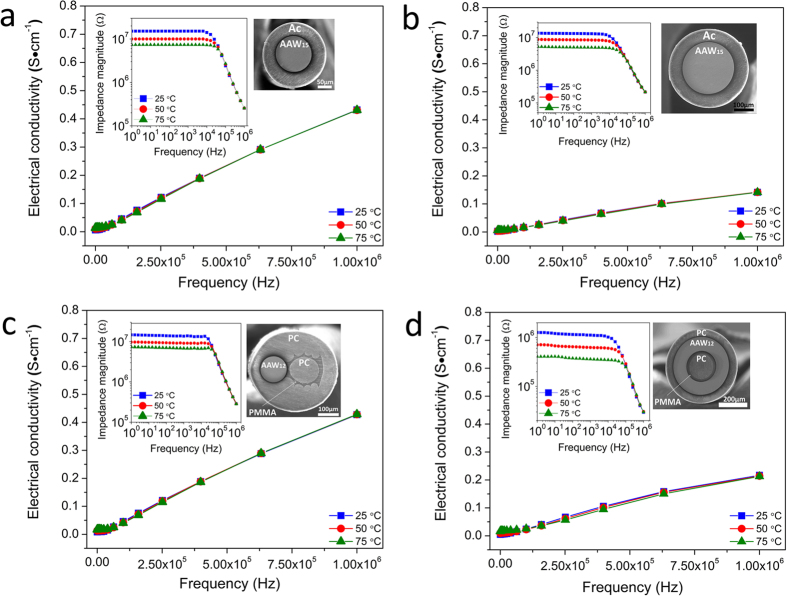
Electrical conductivity with the AC impedance magnitude spectra in inset as a function of the frequency at different temperatures for: (a,b) the 125 μm and 250 μm diameter single-core AAW15 glass fibers with acrylic coating (Ac); (c) the dual-core fiber with 125 μm diameter AAW12 glass and 140 μm diameter PC cores and (d) the ring-core fiber with a PC cladding ring of 45 μm thickness, an electrically conductive AAW12 glass ring of 90 μm thickness, a PMMA ring of 25 μm thickness, and a PC core of 155 μm diameter. Fiber length: 15 cm. Glass labels: AAW12: 45AgI-43-AgPO3-12WO3, AAW15: 45AgI-40-AgPO3-15WO3.